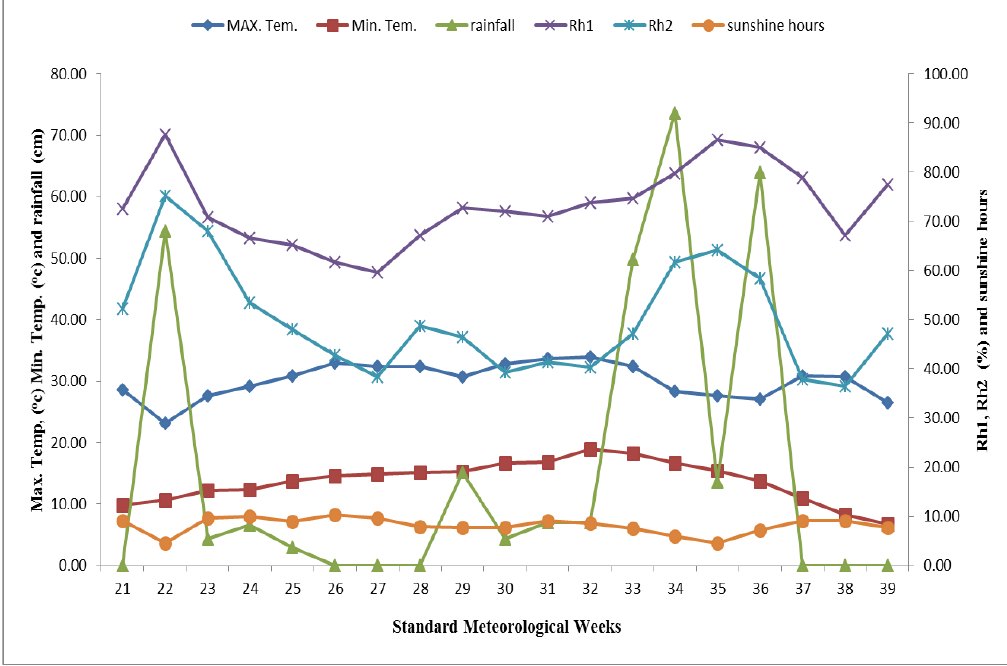
Figure 2. Mean meteorological data during maize crop growth season of 2020. Where, SSH means Sunshine hours, RH 1 and RH 2 means maximum and minimum relative humidity.